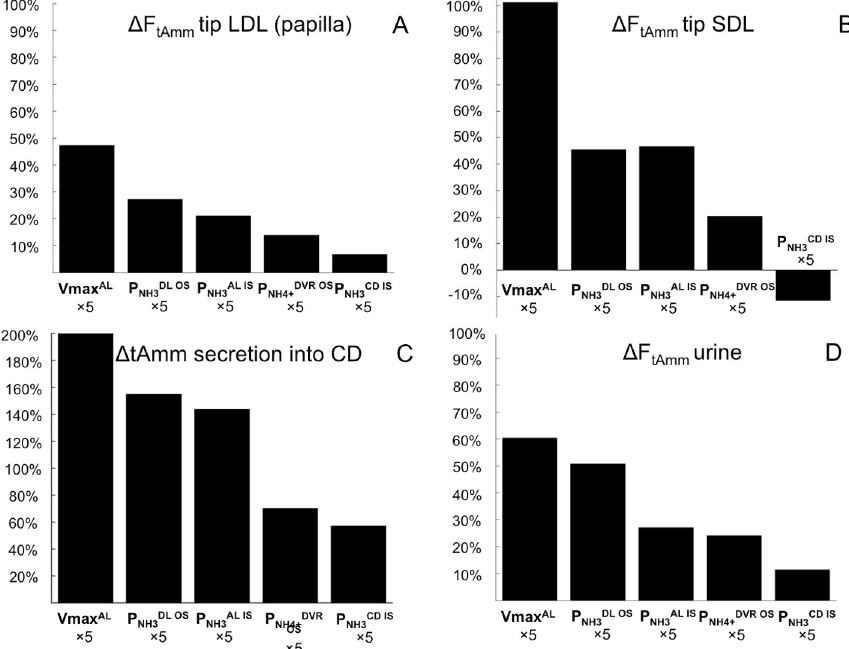
Fig 6. Parameter study. %changes in total ammonia flows resulting from multiplying each baseline parameter by 5: A) changes at the papillary tip of long loops, B) changes at the tip of short loops (outer-inner medullary junction), C) changes in total ammonia secretion into the collecting ducts, D) changes in urinary excretion. Parameters associated with ammonia recycling in the loops of Henle (especially of short nephrons, see B) are associated with the largest increase in urinary ammonia flow (D). The figure only shows the parameters that affect urinary ammonia excretion by at least 10%. Vmax AL : maximum rate of active transport in thick ascending limbs; P DLOS NH / P ALIS NH / P CSIS NH NH 3 permeability of outer stripe descending limbs/ inner of NH þ 4 3 3 3 stripe ascending limbs/ inner stripe collecting ducts; P DVRIS NH þ NH þ permeability in descending vasa recta of the 4 4 inner